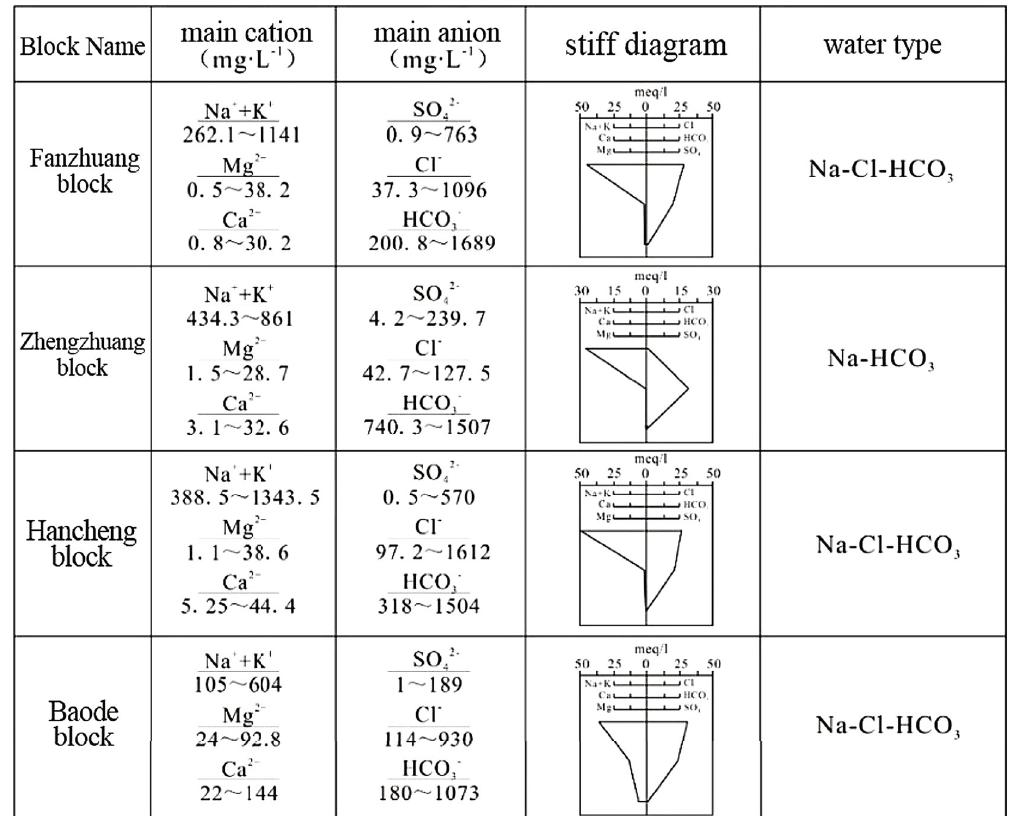
Figure 2: Geochemical characteristics of groundwater in typical blocks of North